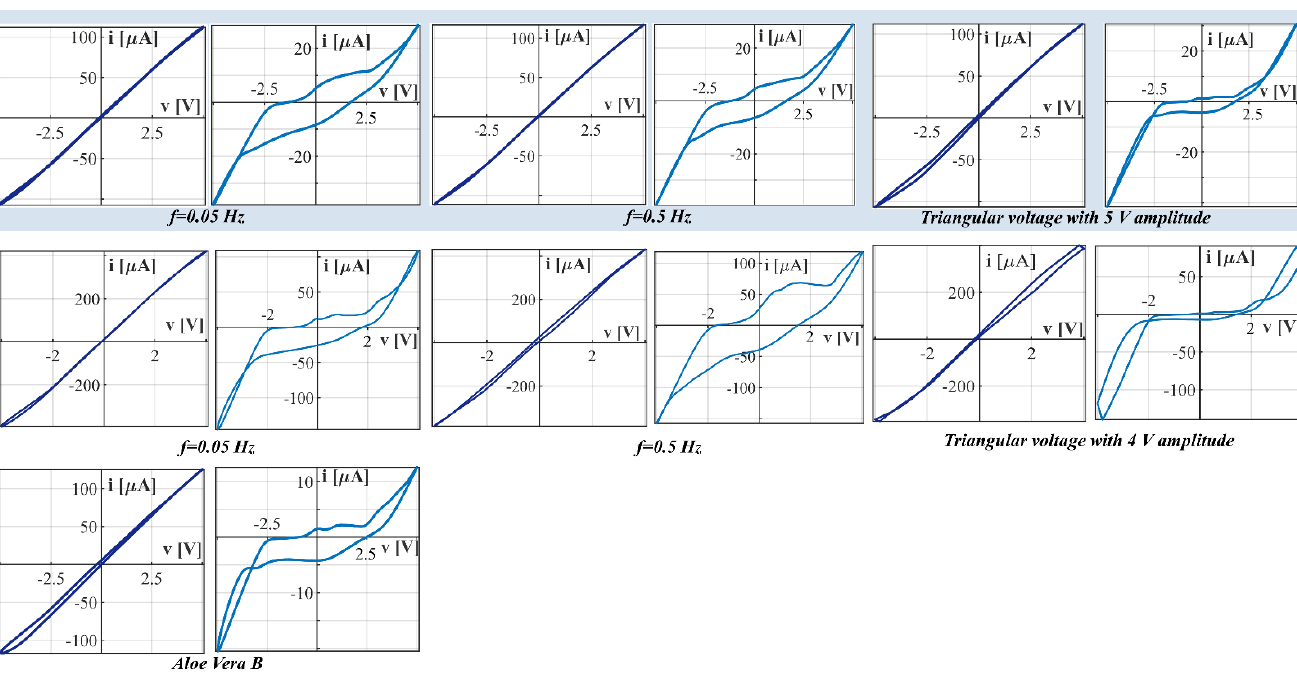
Fig. S1: Additional voltage current plots recorded from the aloe vera plants, always shown for the second period of each measurement. The dark blue plots represent the results from recordings with the silver/silver chloride electrode and the light blue plots from the recordings with the stainless steel needle electrode. a ) Results from the leaf of one aloe vera plant (A) shown for applied sinusoidal voltage with an amplitude of 5 V and frequency equal to 0.05 Hz and frequency equal to 0.5 Hz and triangular voltage with 5 V amplitude and frequency of 0.005Hz. b ) Results from the extracted liquid of one aloe vera leaf shown for applied sinusoidal voltage with an amplitude of 4 V and frequency of 0.05 Hz and 0.5 Hz and triangular voltage with an amplitude of 4 V and frequency of 0.005 Hz. c ) Results from the leaf of another aloe vera plant (B) shown for sinusoidal voltage with an amplitude of 5 V and frequency f = 0.005